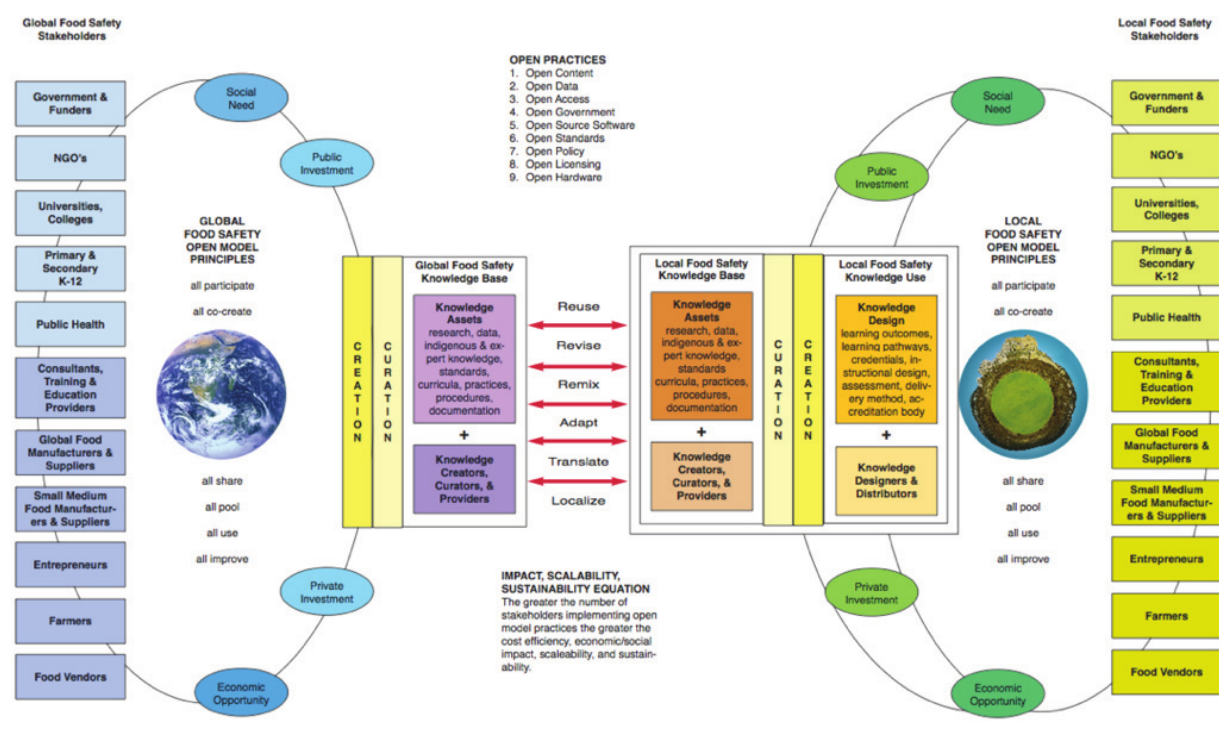
Figure 1. Open Ecosystem Engagement strategy. On the left are global stakeholders who, driven by social needs and economic opportunities, are making public and private investments and creating a coordinated approach to improving food safety. To generate maximum value through open models all global stakeholders adopt open principles which have everyone participating, co-creating, sharing, pooling, using and improving. Nine different open practices can be adopted as a means of fulfilling those principles. Definitions for each of these nine open practices, examples of success, and sample stakeholder value propositions associated with them are in Appendix A at the end of this paper. Collectively this generates an open global food safety knowledge base made up of knowledge assets (e.g. text, graphics, sound, video, lists of experts and expert networks, etc.) and knowledge creators, curators and providers. Local food safety stakeholders are shown on the far right. While the categories are the same the actual organizations are different. To generate maximum value through open models all local stakeholders adopt open principles which have everyone participating, co-creating, sharing, pooling, using and improving. The same nine different open practices can be adopted as a means of fulfilling those principles. Collectively this generates an open local food